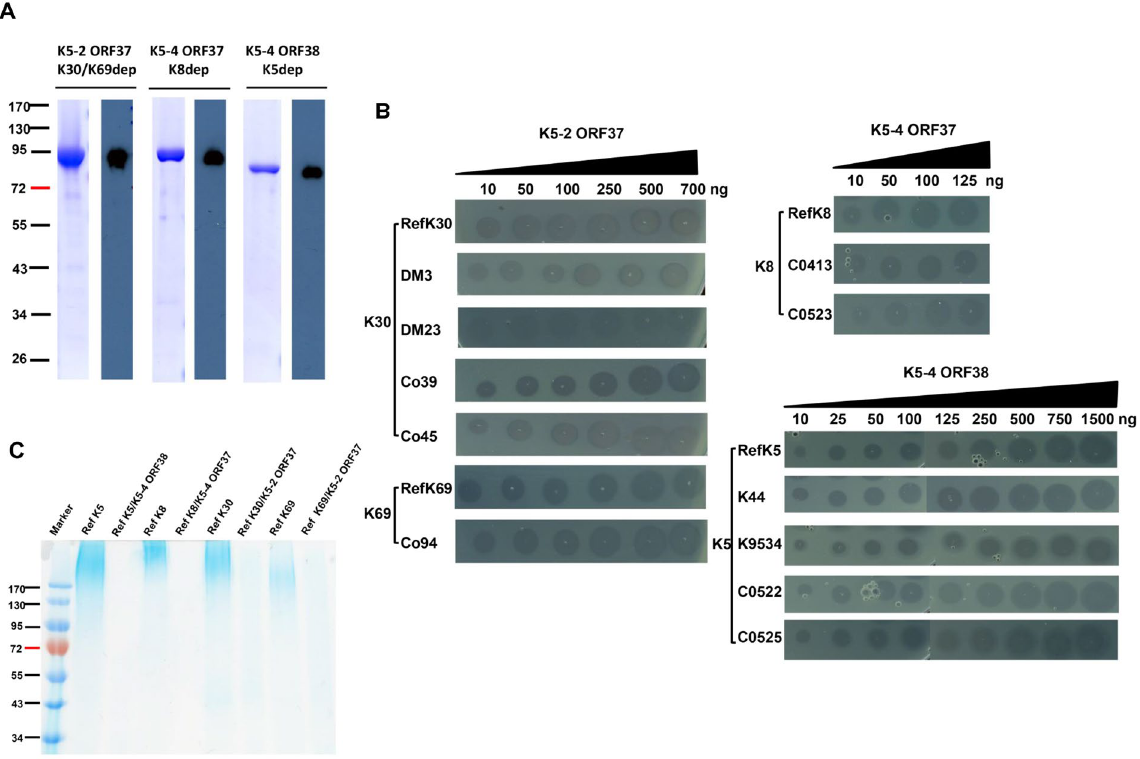
Figure 3. Capsule depolymerase expression of phages K5-2 and K5-4 and enzymatic activity of their purified capsule depolymerases. ( A ) Purity of recombinant K5-2 ORF37, K5-4 ORF37 and K5-4 ORF38 proteins. The purified K5-2 ORF37, K5-4 ORF37 and K5-4 ORF38 proteins were separated on SDS-PAGE with Coomassie blue staining, and the molecular weights were indicated beside the protein markers. Immunoblots showing the purified recombinant proteins were separated by SDS-PAGE, transferred onto a nitrocellulose membrane, and detected using a mouse anti-His antibody (1:5000) and a rabbit anti-mouse IgG-HRP (1:10,000). ( B ) Activity of purified K5-2 ORF37, K5-4 ORF37 and K5-4 ORF38 proteins among different capsular types in K30, K69, K8 and K5 Klebsiella strains. Five K30 strains (ref K30, DM3, DM23, Co39 and Co45 and two K69 strains (ref K69 and Co94) were spotted with K5-2 ORF37 protein (10–700 ng). Three K8 strains (ref K8, C0413 and C0523) and five K5 strains (ref K5, K44, K9534, C0522 and C0525) were spotted with K5-4 ORF37 protein (10–125 ng)